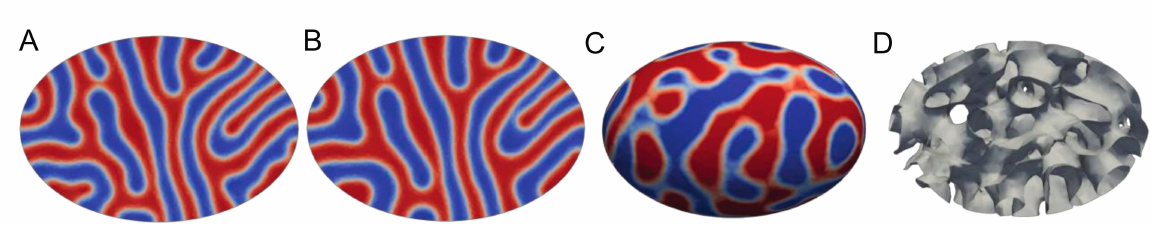
Figure 7. Simulation results on a 3D sphere domain with a radius of five and a single calcium phosphate granule. The time step ∆ t = 0.001 for ( A ) t 500 , ( B ) the inside contour of ( A ), ( C ) t 1500 , and ( D ) the inside contour of ( C ). The orange object represents the calcium phosphate granule.